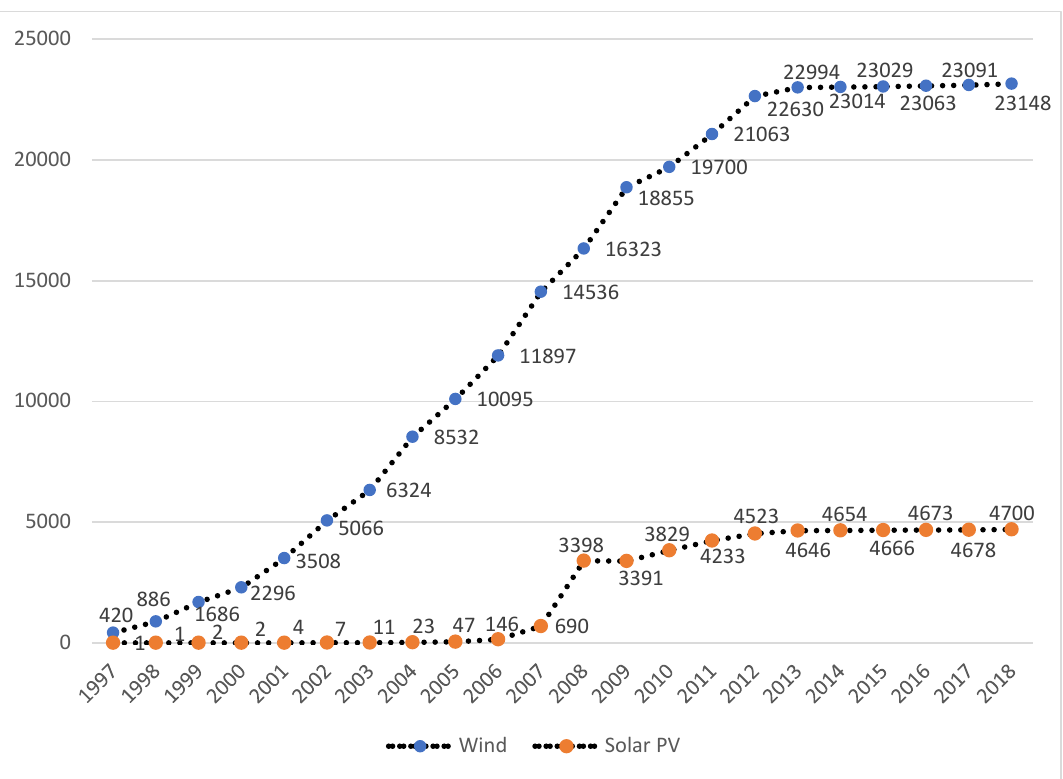
Figure 1. Renewable Power Capacity (Megawatts). Source: